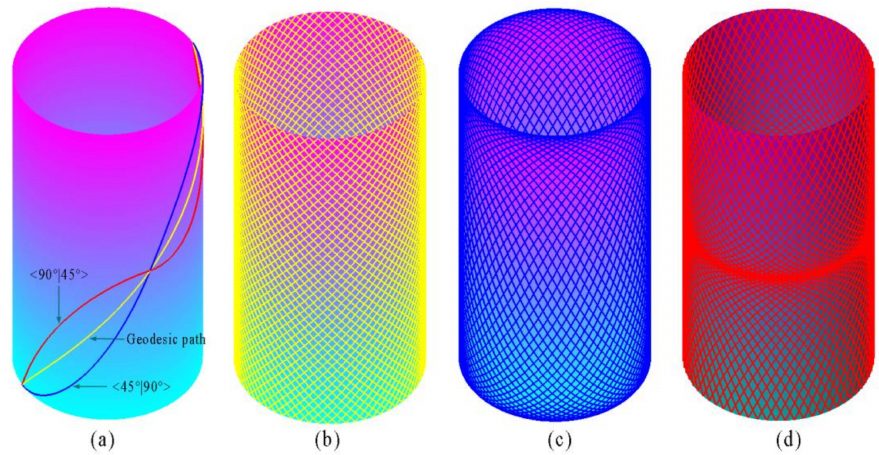
Figure 4. Simulation of fiber path with different initial fiber angle and end fiber angle on